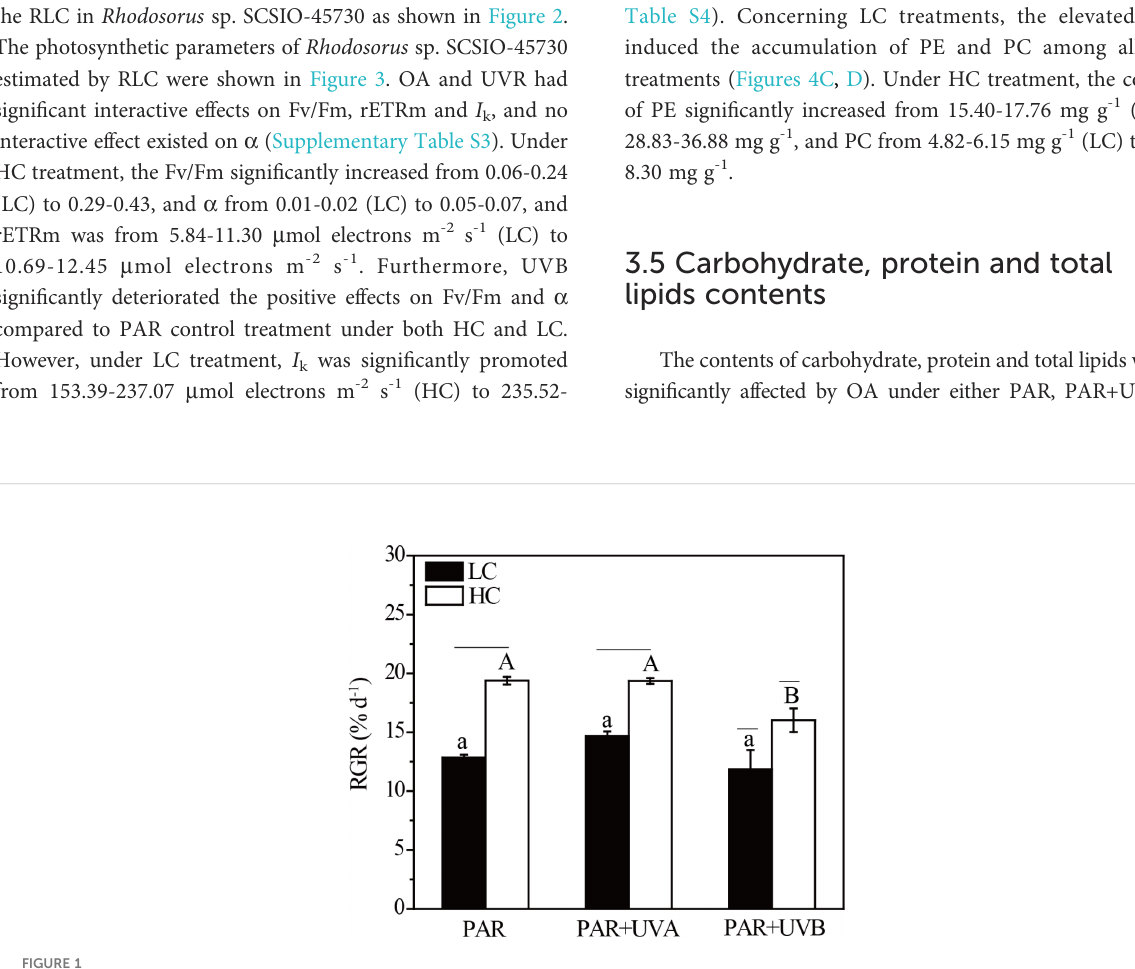
FIGURE 1 The relative growth rate (RGR) of Rhodosorus sp. SCSIO-45730 treated under different p CO 2 levels and UVR. Short horizontal lines represent signi fi cant differences (P<0.05) among CO 2 treatments at the same UVR treatment, while long horizontal lines indicate insigni fi cant differences. Different lowercase letters represent signi fi cant differences (P<0.05) among UVR treatments under LC, and different capital letters indicate signi fi cant differences (P<0.05) among UVR treatments under